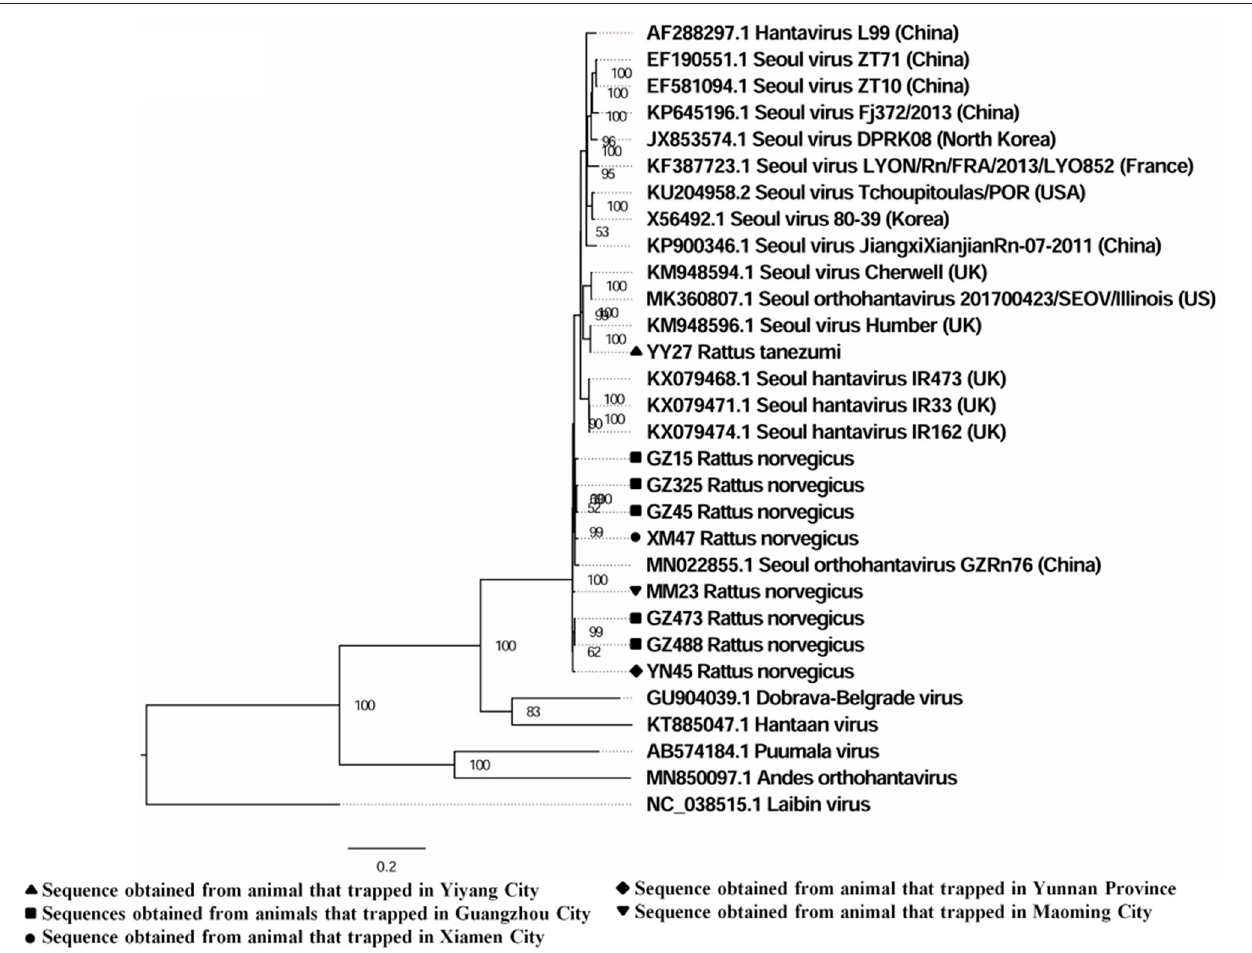
FIGURE 5 | Phylogenetic tree constructed using nucleotide sequences of the Seoul virus L gene obtained from rats. Twenty representative orthohantavirus sequences were included for comparison, and one Laibin virus sequence was set as the outgroup. The percentages of the posterior probability (PP) values are